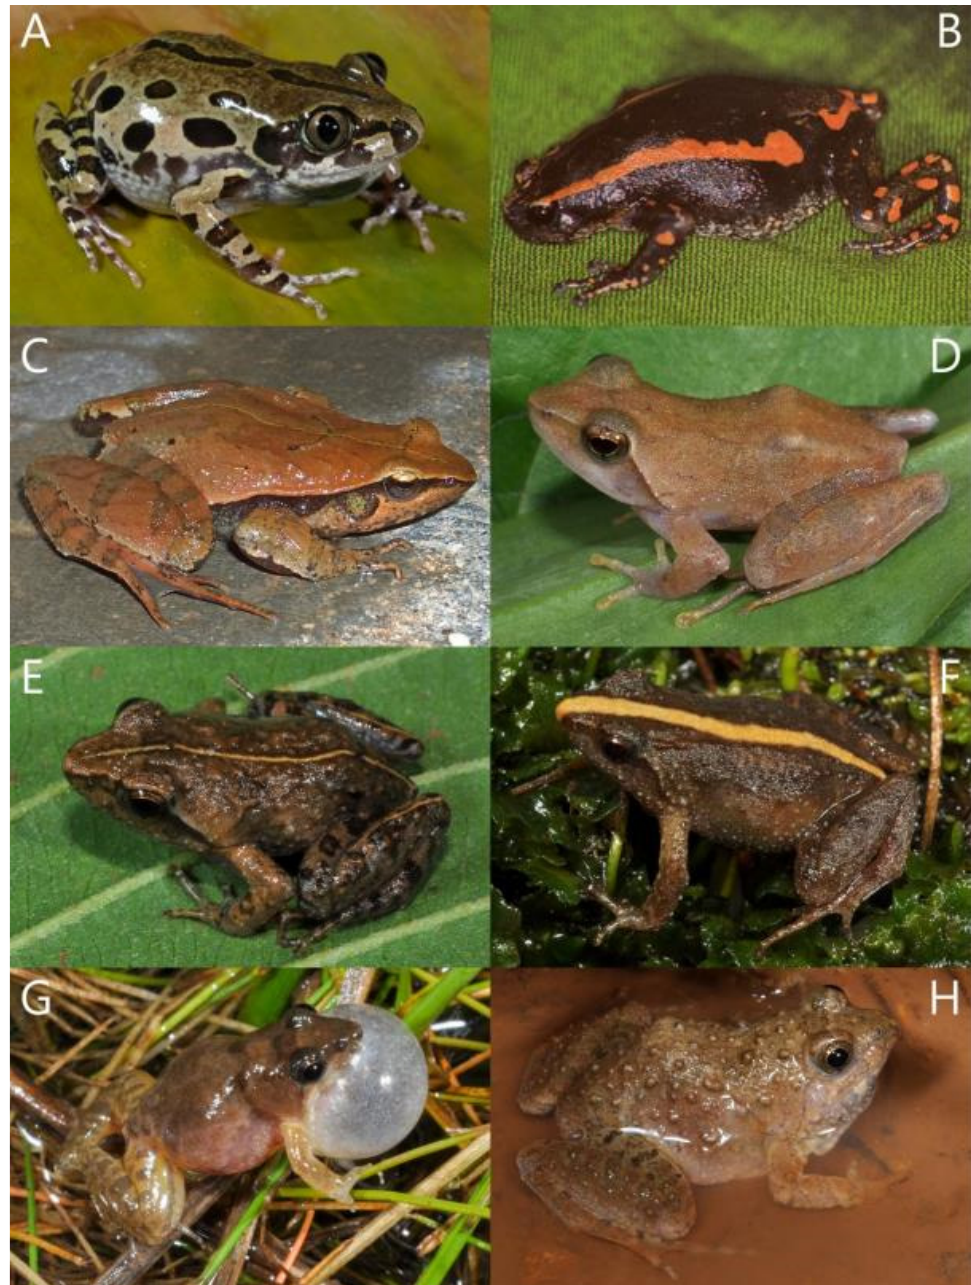
Figure 10. Rwandan species of Hyperoliidae ( A ) Kassina senegalensis , Huye (photo: J.M.D.); Microhyl- idae ( B ) Phrynomantis bifasciatus , Eastern Province (photo: Eberhard Fischer); and Phrynobatrachidae ( C ) Phrynobatrachus acutirostris , Nyungwe NP (photo: Eberhard Fischer), ( D ) Phrynobatrachus auritus , Libreville, Gabon (photo: J.M.D.), ( E ) Phrynobatrachus bequaerti , Rugezi Wetland (photo: J.M.D.), ( F